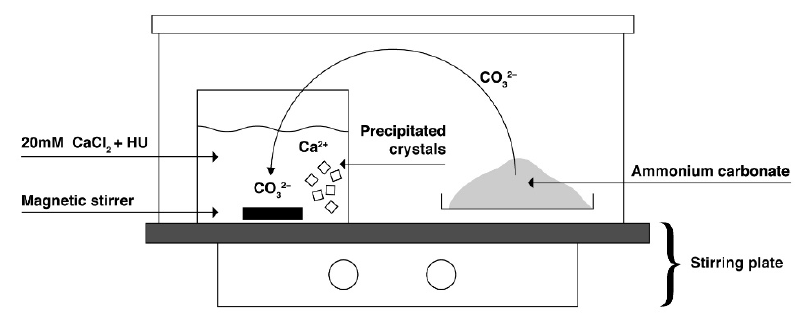
Figure 1. Illustration of the experimental setup for the synthesis of calcite.